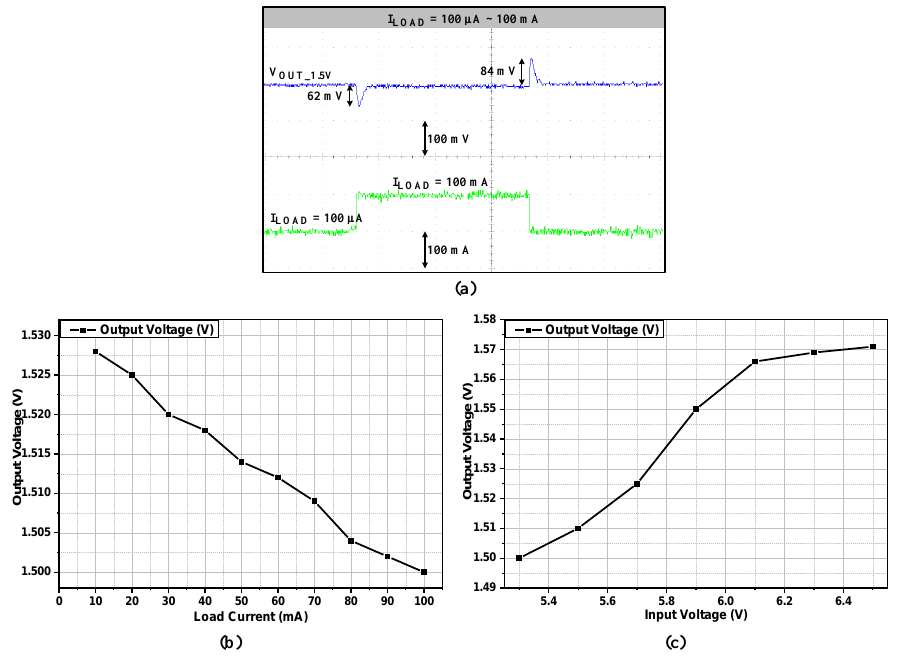
Figure 10. Measured results of LDO_1.5V. ( a ) Load transient response from 100 µ A to 100 mA. ( b ) Load regulation. ( c ) Line